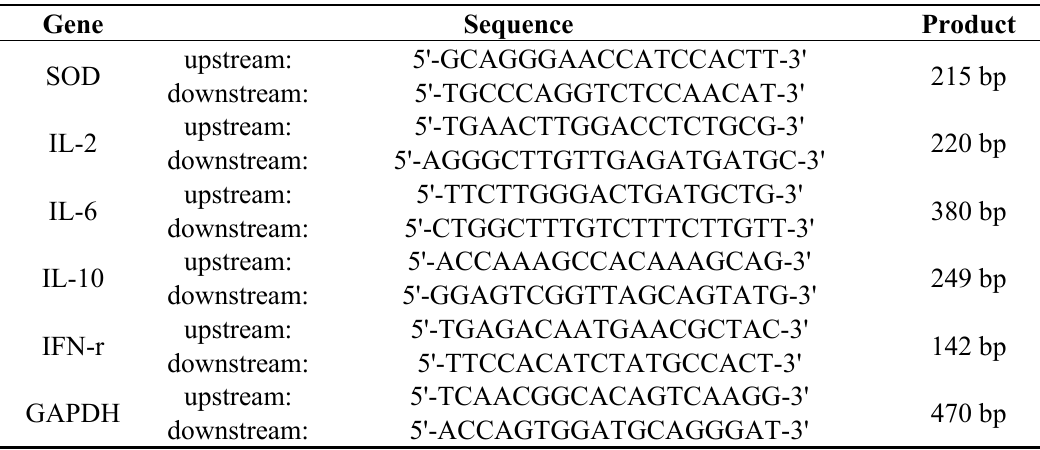
Table 2. Primers for Real-time